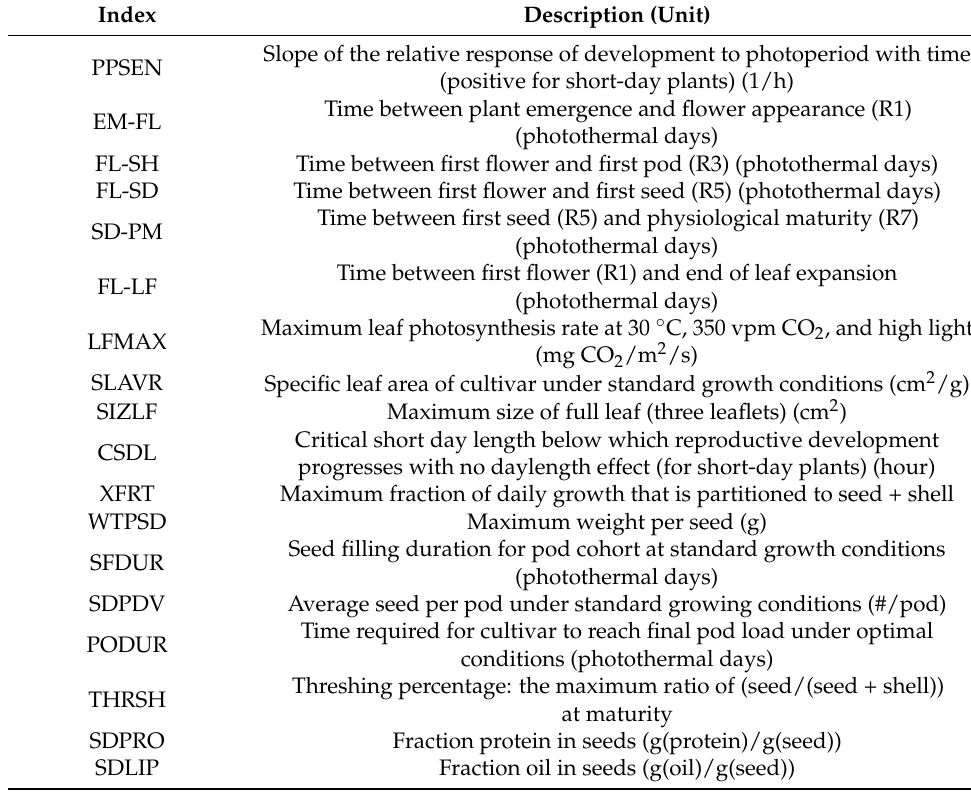
Table 2. Genotype coefficients of bell pepper in